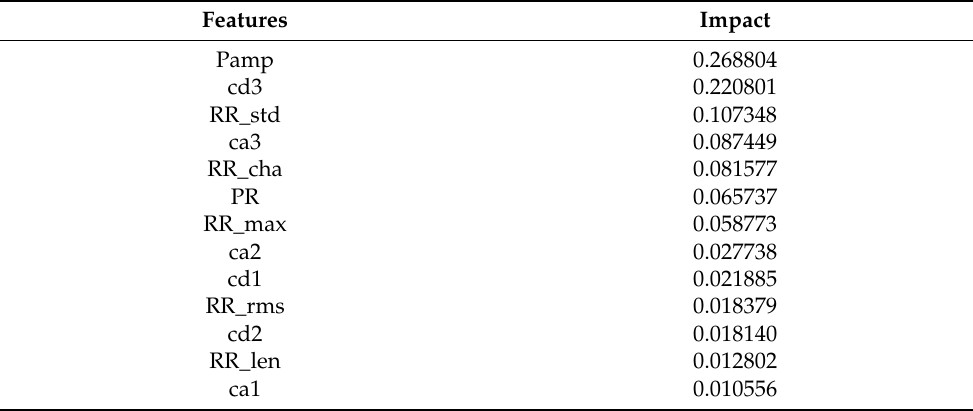
Table 3. Importance of selected features.